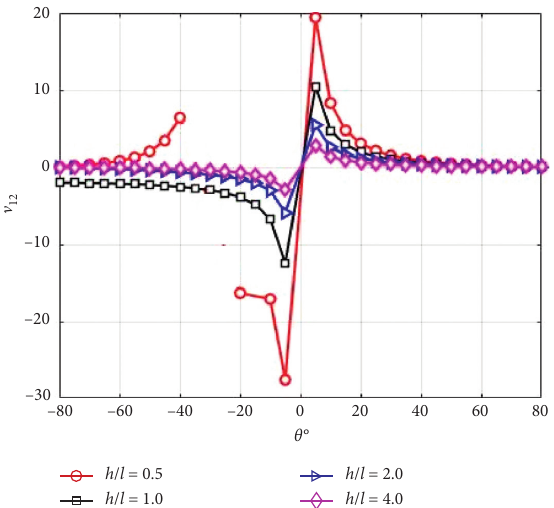
Figure 3: Effect of cell angle on Poisson’s ratio with different h/l